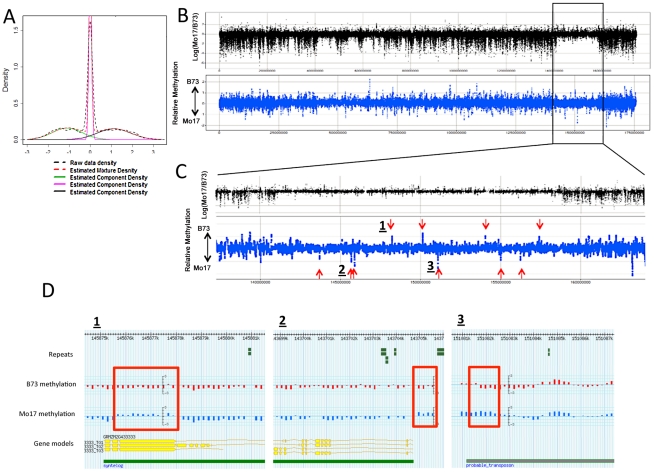
DMRs in B73 and Mo17.(A) The relative methylation levels for all probes were used to perform DNAcopy segmentation followed by expectation maximization. The black dashed lines show the observed distribution of the segment means. This distribution can be approximated (red dashed line) by a model that is derived from three normal distributions including B73 hypermethylation (right peak), Mo17 hypermethylation (left peak) and unchanged regions (middle peak). (B) The structural variation across chromosome 8 is shown in the plot with black spots. The blue spots show relative methylation in B73 and Mo17. The region of low structural diversity (boxed region) is magnified in (C). (D) Gbrowse views for three DMRs located within this region are shown. The data tracks show the position of repeats, genes, B73 methylation, Mo17 methylation and relative methylation. Each bar showing methylation values represents an individual probe. The actual DMRs are shown by the red boxes.